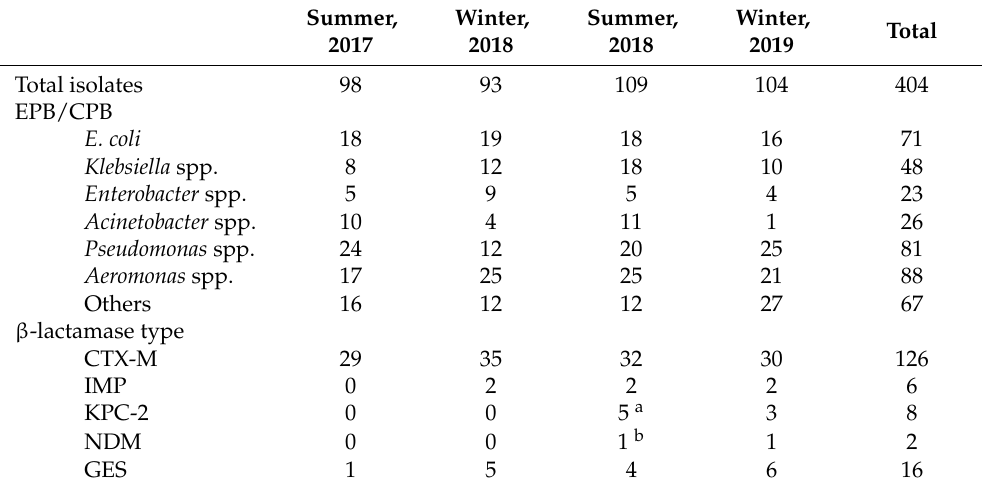
Table 1. Whole-Genome Sequencing of CHROMagar ESBL-Positive Isolates Obtained from